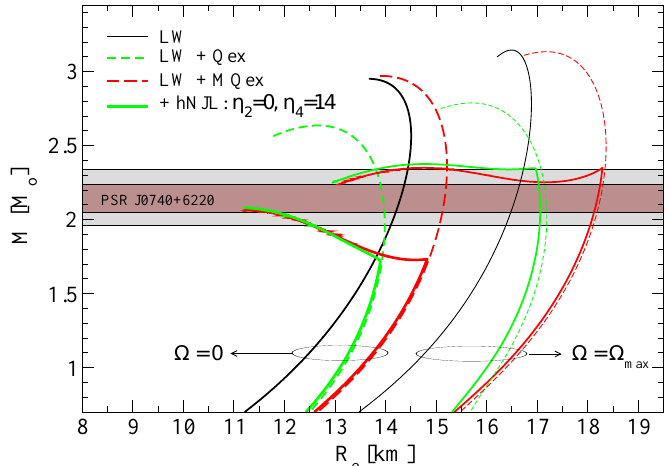
Figure 11. Mass-radius relation for neutron stars within the LW model (black dotted lines) modified by quark exchange effects within two different schemes for the density dependence of the quark mass: constant quark mass (LW + Qex, green short-dashed line) and Brown-Rho scaling (LW + MQex, red long-dashed line). The bold lines are for nonrotating star sequences and the thin lines for the rigidly rotating ones with maximal angular velocity. Results for a deconfinement phase transition to hNJL quark matter core sequences are shown by solid